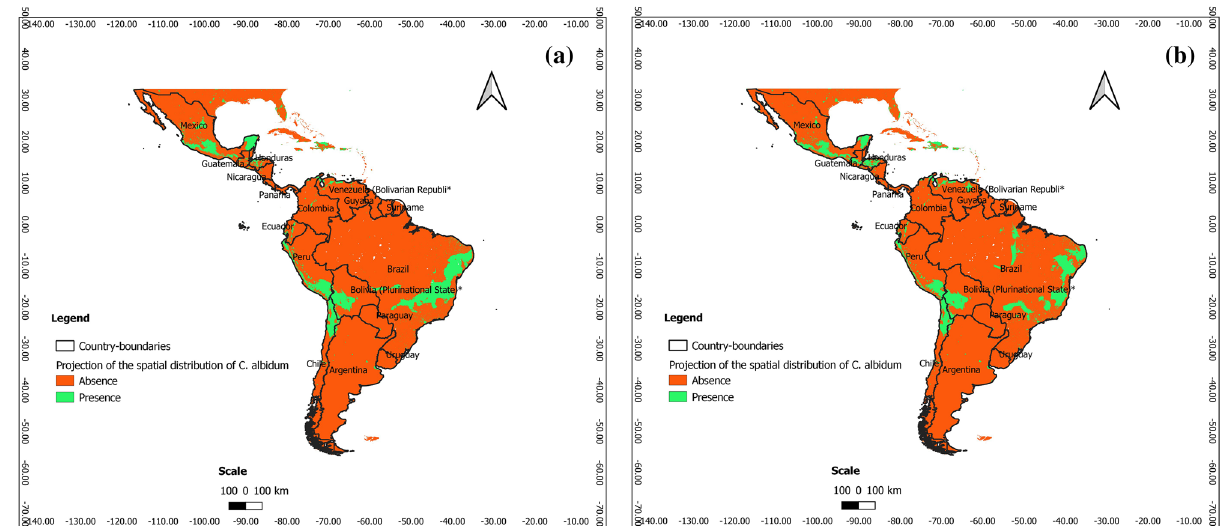
Figure 8. Projections of the spatial distribution of C . albidum according to BRT across Latin America: a) at present; b) at horizon 2060 SSP585 (the maps were generated using R version 4.1.3 (https:// www.R- proje ct. org/), QGIS 3.18.1 (http:// qgis. osgeo. org), and WGS 84 as Coordinate Reference System).